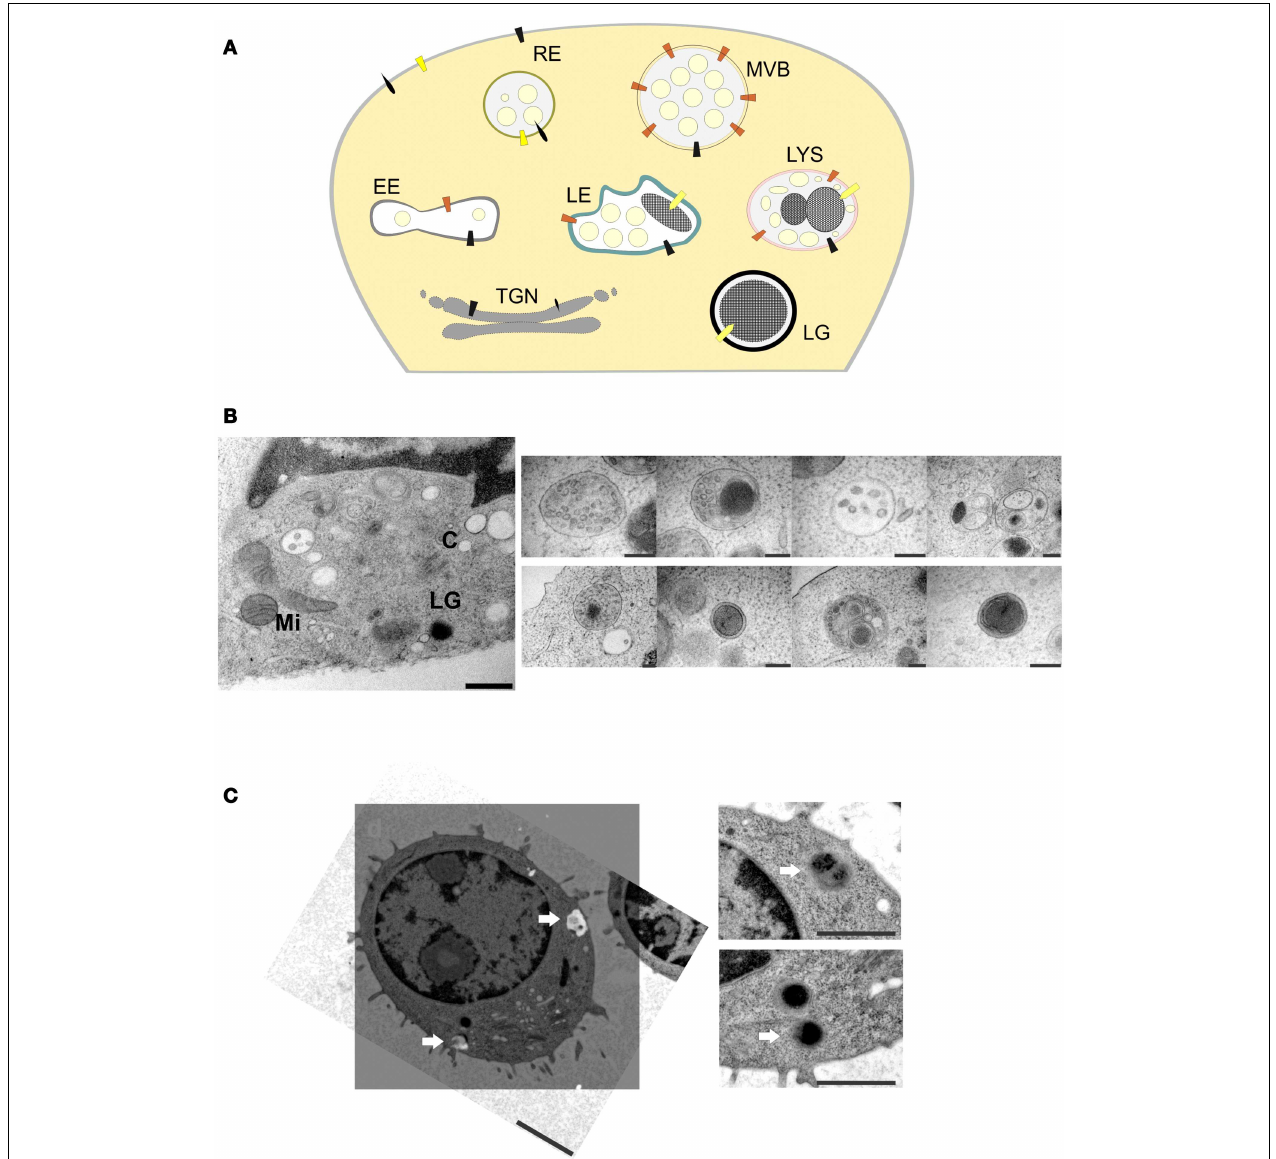
correlative fluorescence electron microscopy (CLEM) image of a primary mouse CTL obtained from synaptobrevin2-mRFP knock in mice (19). Left, EM micrograph (ultrathin section of 80nm) of a mouse CTL with the corresponding processed SIM-image. SIM-image was taken with a 63 × Plan-Apochromat N. A. 1.52 with excitation light of 561nm wavelength, z-stack of 0.2 µ m step size were used to scan a 500nm thick section. Arrows indicate synaptobrevin2-positive lytic granules (scale bar: 2 µ m). Right, enlarged areas with the corresponding organelles (scale bar: 1 µ